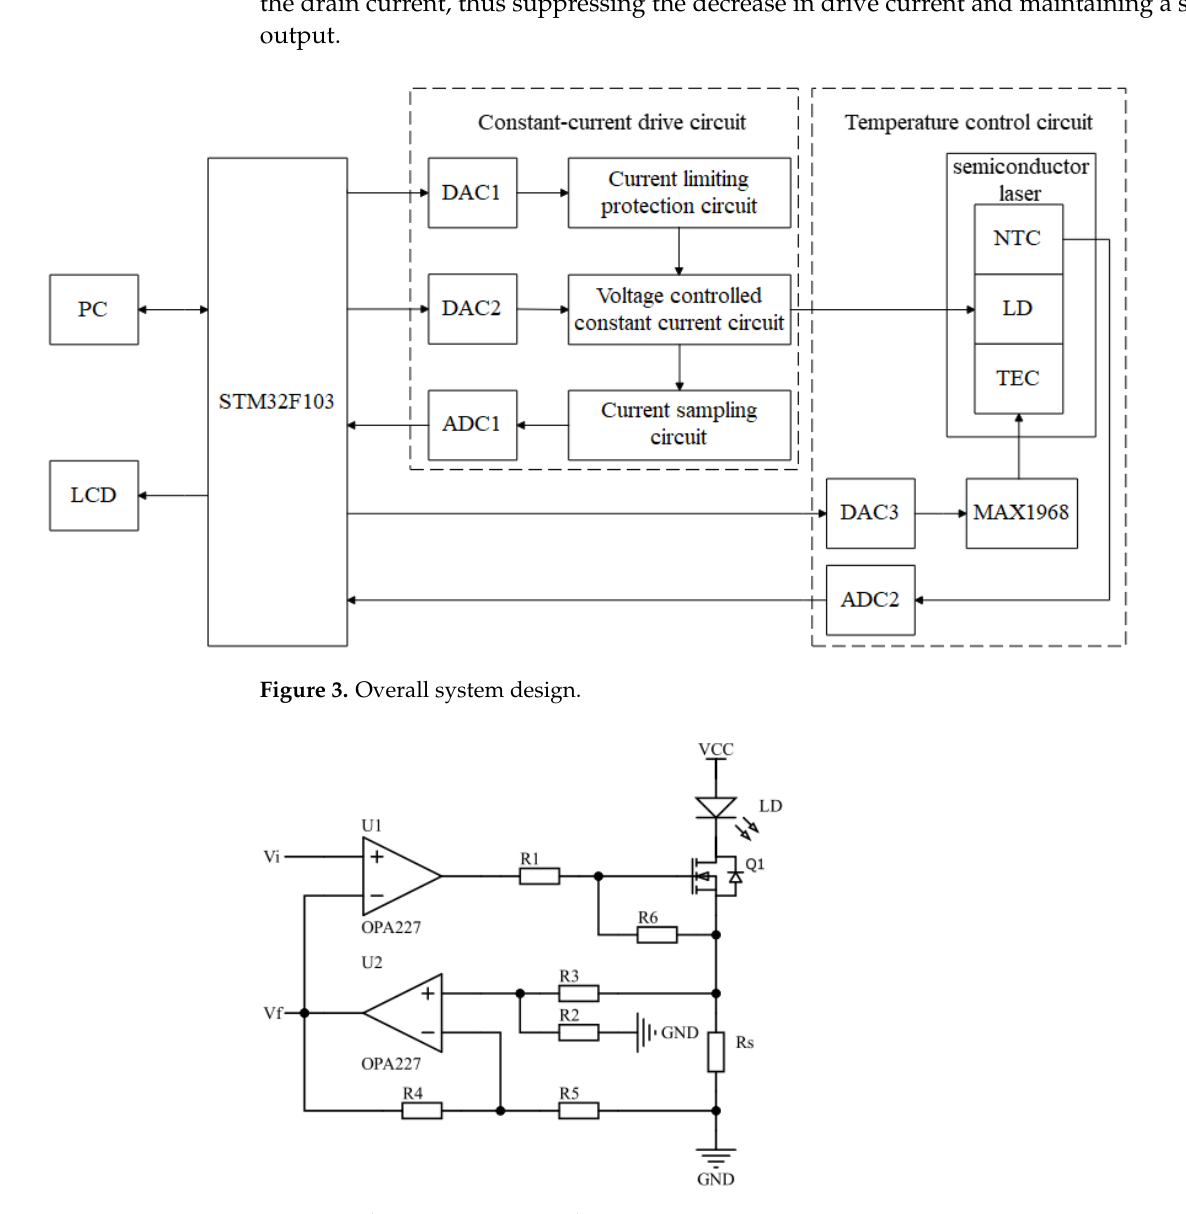
Figure 4. The constant-current driver circuit.